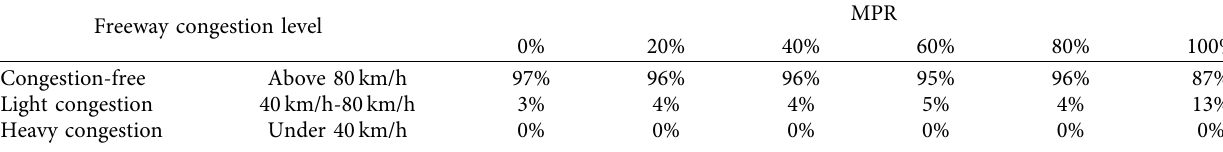
Table 4: Rate of congestion level by